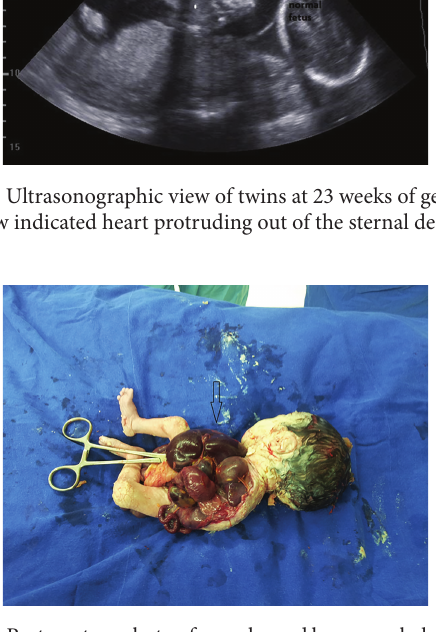
Figure 2: Postmortem photo of case showed large omphalocele with evisceration of all the gastrointestinal organs with absent sternum and rib cage and left upper limb are not